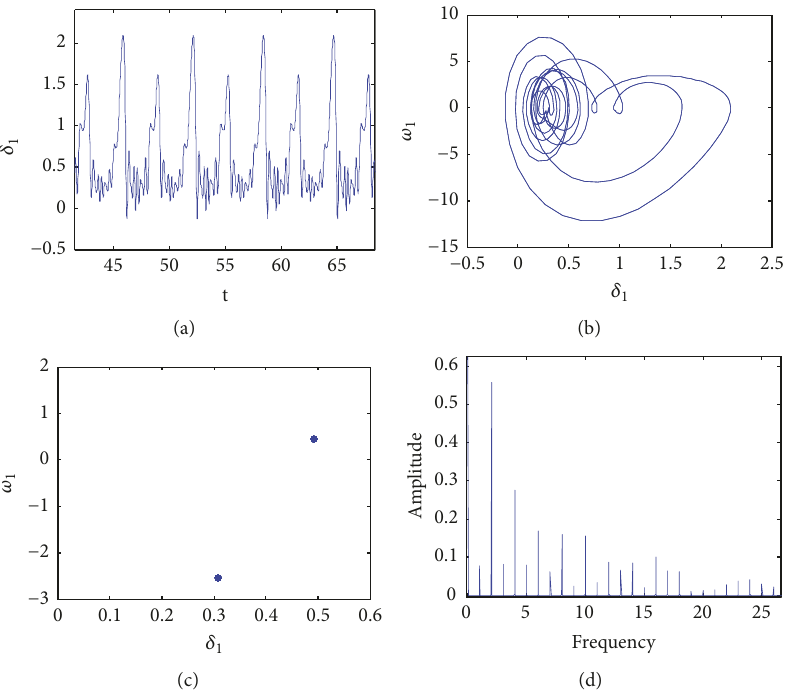
Figure 6: Period 2 motion ( 𝑉 𝐵1 = 0.635 ). (a) Time history. (b) Phase portrait. (c) Poincar´e map. (d) Frequency spectrum.